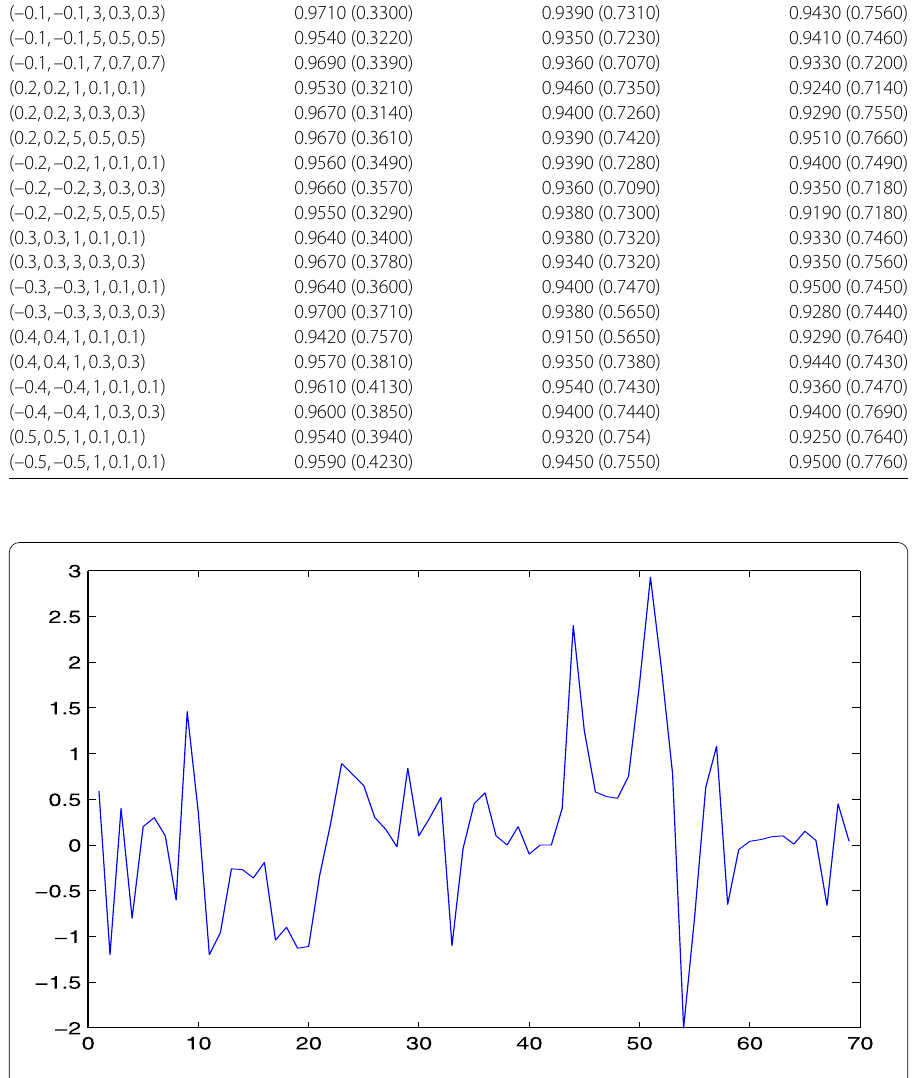
Figure 1 Sample path of transformed data Y